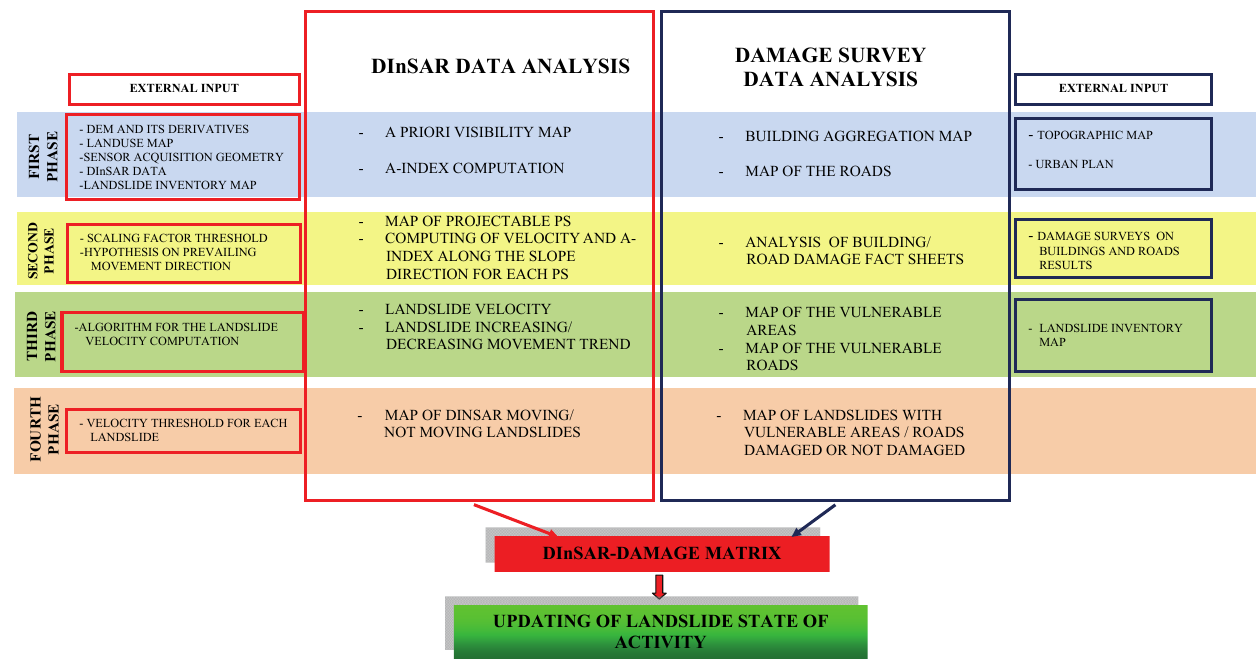
Fig. 6. Flow-chart describing the procedure adopted for the updating of the state of activity of slow-moving landslides.